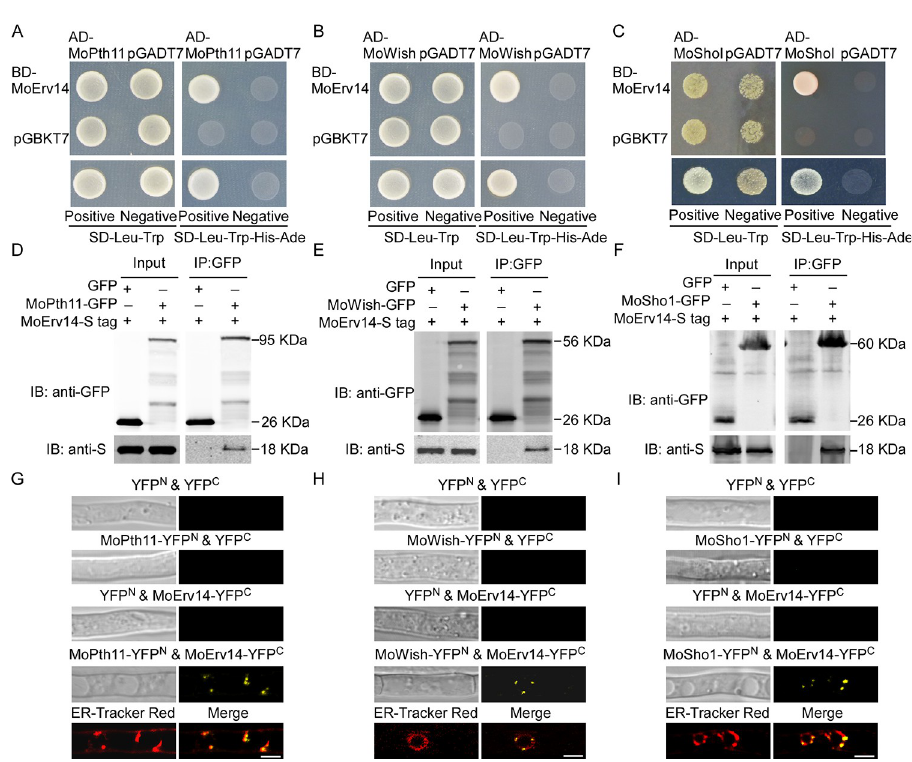
Fig 6. MoErv14 interacts with MoPth11, MoWish, and MoSho1. (A-C) Yeast two-hybrid assay for interactions of MoErv14 with MoPth11, MoWish, and MoSho1. (D-F) Co-immunoprecipitation (Co-IP) assays to detect interactions of MoErv14 with MoPth11, MoWish, and MoSho1. Total proteins were extracted from MoErv14-S tag/MoPth11-GFP, MoErv14-S tag/MoWish-GFP, MoErv14-S tag/MoWish-GFP co-expressing strains, and the MoErv14-S tag/GFP- empty strain. Proteins were then incubated with anti-GFP agarose before being eluted and detected with anti-S tag and anti-GFP antibodies, respectively. (G-I) BiFC assay for the MoPth11 & MoErv14, MoWish & MoErv14 and MoSho1 & MoErv14 interaction in vivo. Hyphae were treated with BFA and examined by DIC and fluorescence microscopy. The strains expressing the MoPth11-YFP N & YFP C , MoErv14-YFP C & empty YFP N , MoWish-YFP N & YFP C , MoSho1-YFP N & YFP C , and empty YFP N and empty YFP C constructs were used as controls. Dye ER-Tracker Red was used to image ER in the interacting strains and merged. Bars = 10 μ m.